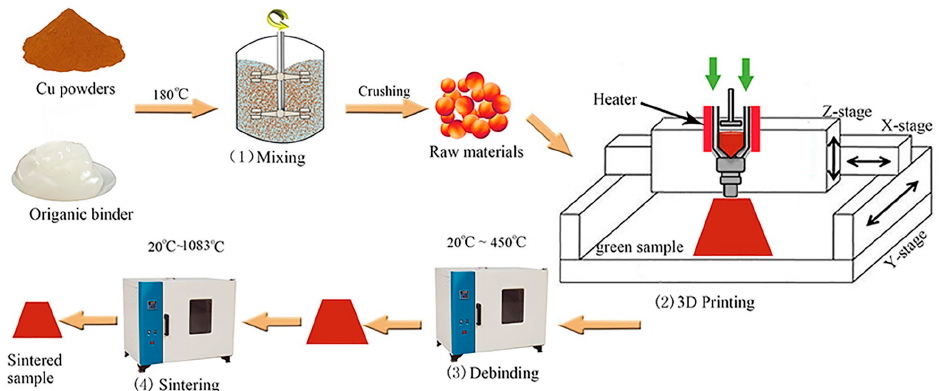
Figure 1. Schematic of the technological process.